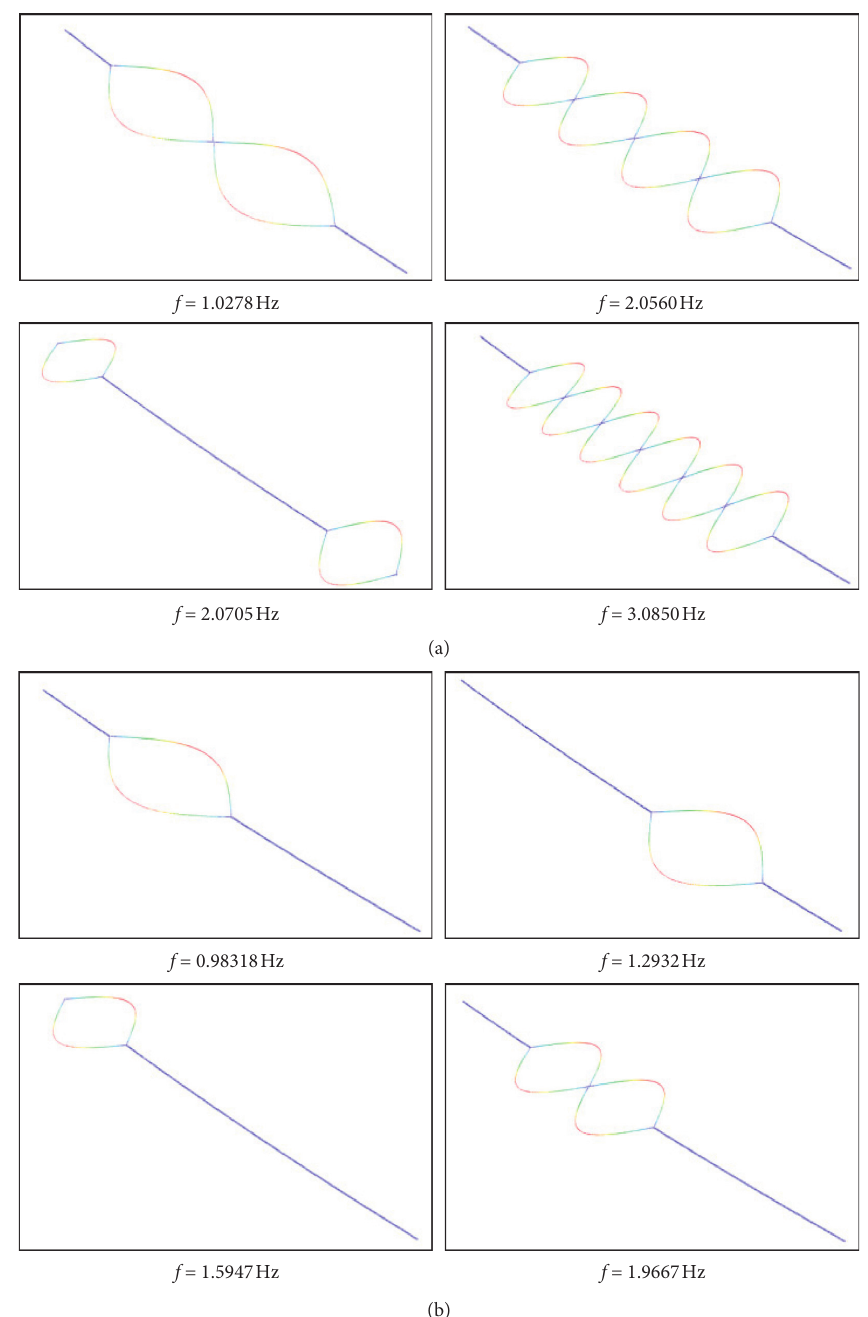
Figure 9: Typical local modes and frequencies of the lines: (a) 200m span line with a symmetric spacer layout and (b) 200m span line with an unsymmetric spacer